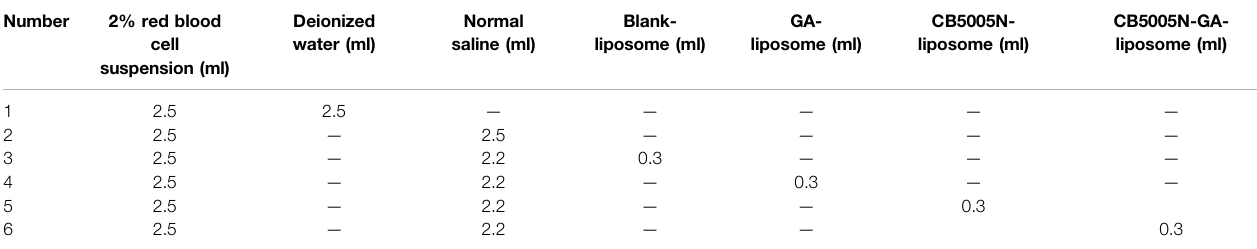
TABLE 1 | Blood safety test plus sample table. Number 2% red blood cell suspension